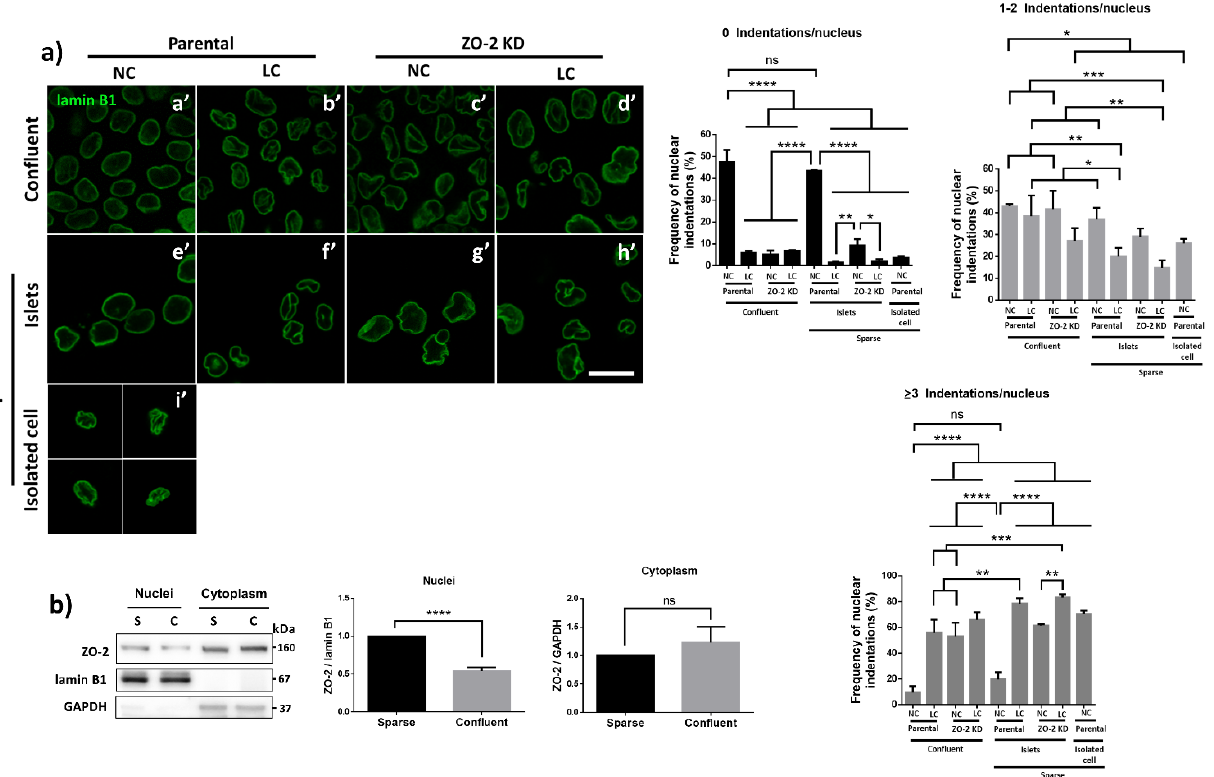
Figure 6. The nuclear shape is altered when the cells are cultured in LC, lack ZO-2 or are devoid of cell–cell contacts. ( a ) Immunofluorescence of lamin B1, in sparse or confluent cultures of parental and ZO-2 KD cells, cultured for 24 h in low calcium (LC, 1–5 µ M Ca 2+ ) or normal calcium (NC, 1.8 mM) media. Left panel, representative images; right panels, quantitative analysis of nuclear indentations. Statistical analysis was done with One-way ANOVA followed by Tukey’s multiple comparisons test. Results are shown as media ± standard deviation. ns, non-significant; * p < 0.05; ** p = 0.01; *** p = 0.001; **** p < 0.0001. ( b ) Western blot analysis of ZO-2 present in cytoplasmic and nuclear fractions derived from sparse (S) and confluent (C) cultures of parental MDCK cells. Lamin B1 and GAPDH were employed as markers and loading controls for nuclear and cytoplasmic fractions, respectively. Left, representative images; right quantitative analysis. Results from three independent experiments. Statistical analysis was done with Student’s t -test. Results are shown as media ± standard deviation. ns, non-significant; **** p < 0.0001.